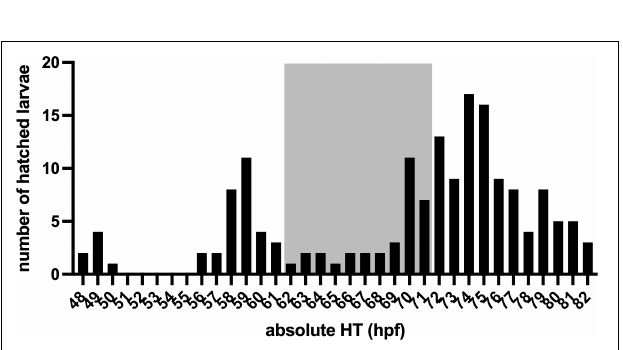
FIGURE 3 | A representative graph of the light dark challenge assay: After an initial acclimation period of 10 min in the illuminated chamber (A), video tracking was initiated for another 10 min (A V ) before the larvae were subjected to a dark challenge phase of 5 min (D 1 ) and another light challenge phase of 10 min (L 1 ). This challenge chain of dark and light phases was repeated three times (D 2 –L 3 ), thus resulting in six alternating dark and light challenge phases. Swimming activity as distance moved (D, mm) typically shows intermediate levels during acclimation, elevated levels during the dark challenge and reduced levels during light challenge levels (mean ± SD, N =